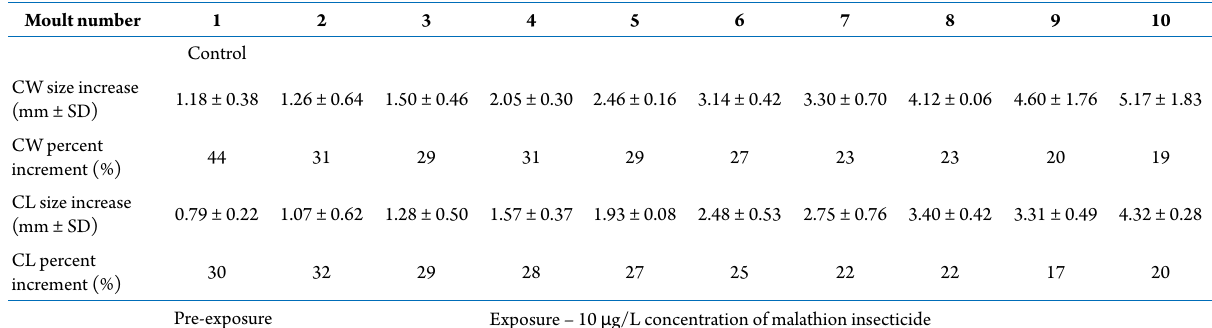
Table 1. Mean size increase for carapace width (CW) and carapace length (CL) with standard deviations (SD), along with percentage size increments for control and malathion-exposed cohorts of Poppiana dentata crabs.